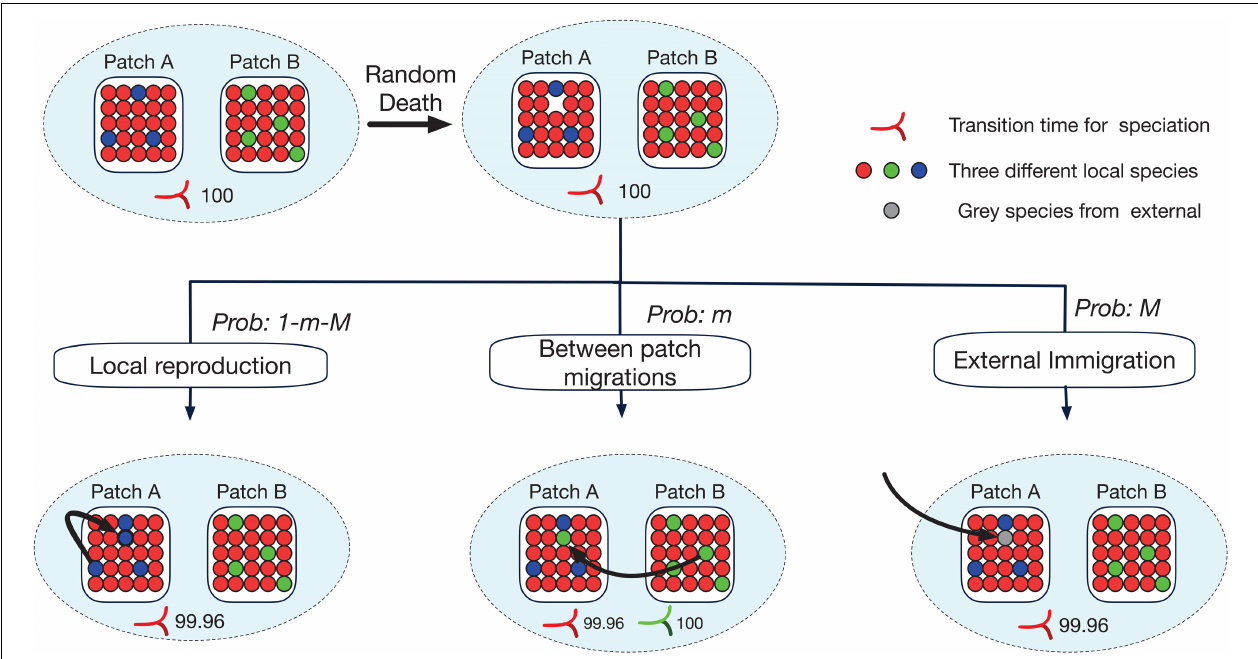
FIGURE 2 | Schematic representation of the network structure used in our study. In this example, we show three initial species (red, blue, and green) in the community network of two patches (A and B). There are 50 individuals in total. The time step shown represents a birth-death cycle: that is 2/50 = 0.04 of a generation. The minimum duration of speciation ( τ ) is set at 100 generations meaning that in the absence of gene flow speciation will complete in 100 generations. The gene flow effect (G) is 5 in this example meaning that every individual gene flow event causes a 5-generation delay to the conclusion of the speciation process. The numbers at the bottom of each panel are the speciation ‘clocks’ for each species showing how many generations without gene flow are required to completely sever that species into two. Only when a species has conspecific populations in different patches is a speciation ‘clock’ required. Any ‘clock’ is initialized with τ generations (here 100), and will then count down over time but increase by G whenever a dispersal event of a conspecific occurs (gene